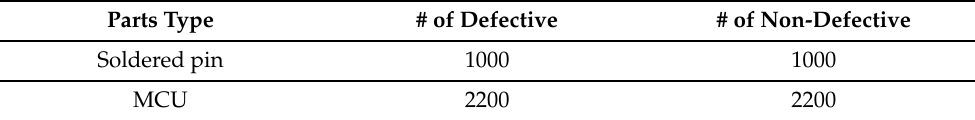
Table 4. PCB parts dataset.